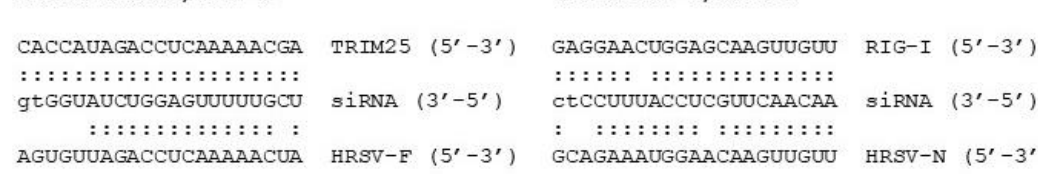
Figure 1. Nucleotide sequence of bispecific siRNAs against viral and cellular genes. The 21-nucleotide long sequence of the two bispecific siRNAs (antisense) silencing TRIM25 and HRSV-F (TRIM25 / HRSV-F) or RIG-I and HRSV-N (RIG-I / HRSV-N) is shown. Dinucleotide overhangs are in lowercase. Canonical base pairing with TRIM25, RIG-I, HRSV-F, or HRSV-N mRNAs are represented by colons.